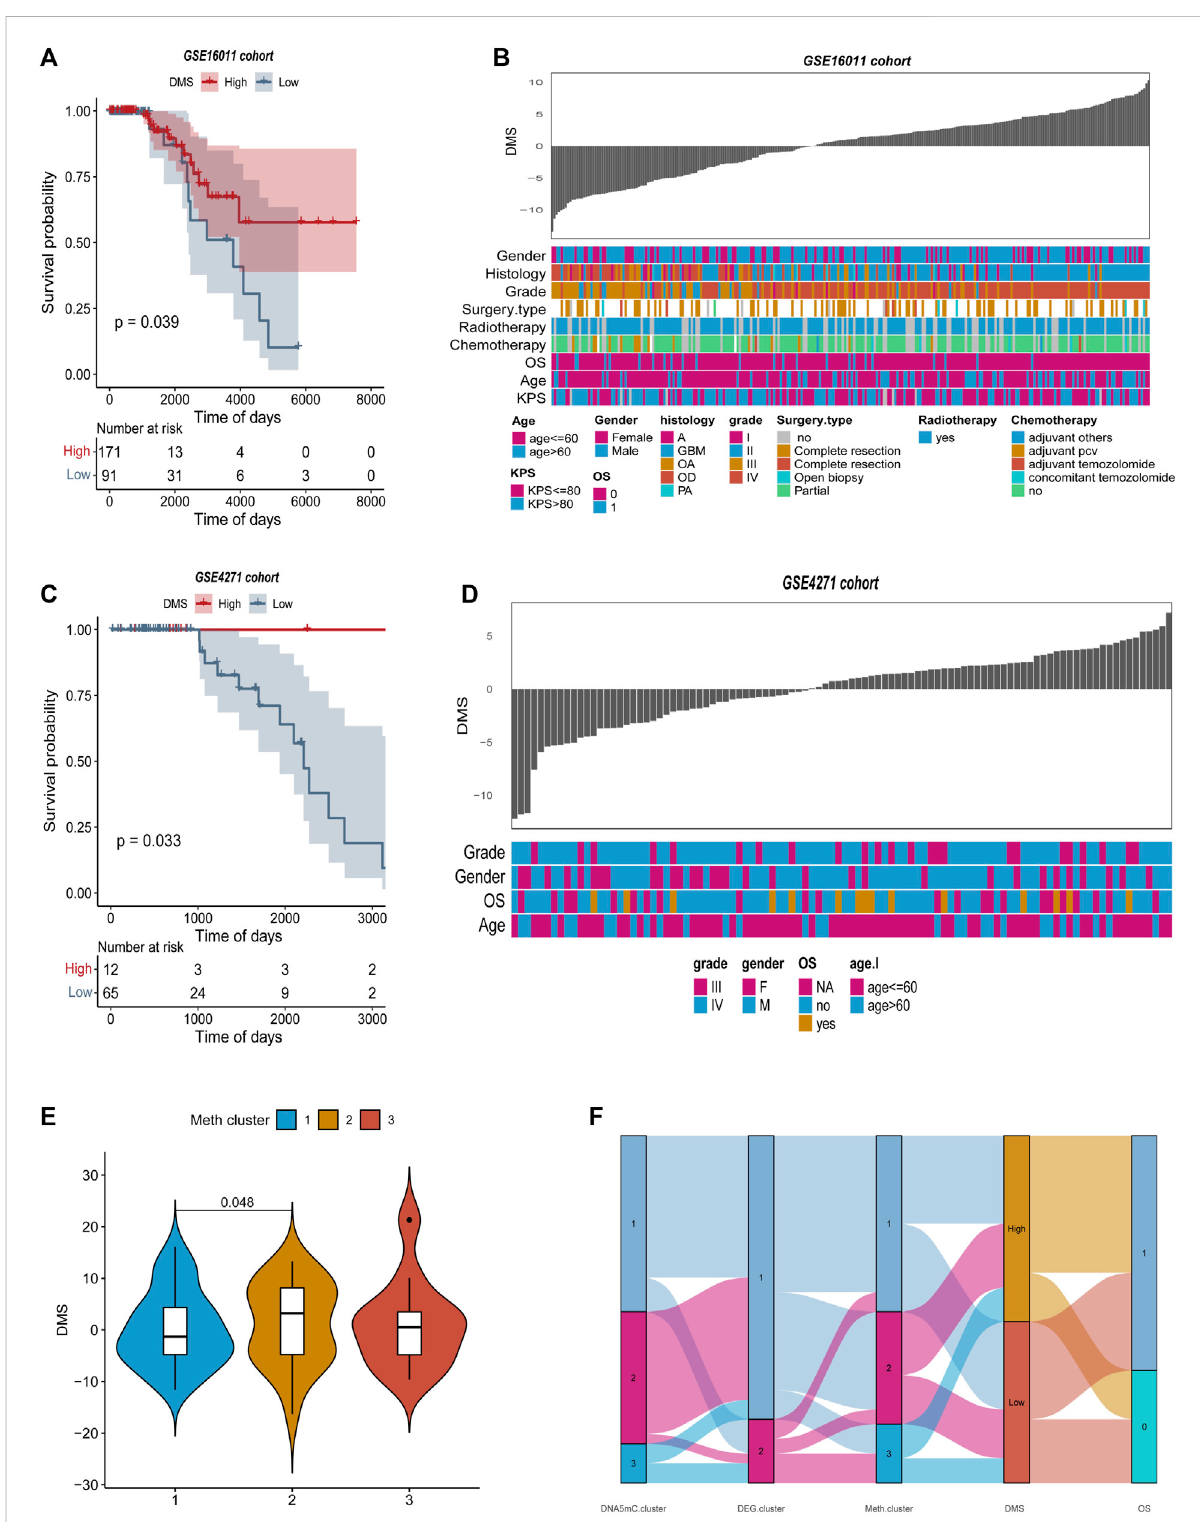
FIGURE 9 Features of tumor DNA methylation scores in external GEO cohorts. (A – B) Survival curves between high and low DMS groups in GSE16011 and GSE4271 datasets, separately. (C – D) Relationship between clinical special diagnosis and DMS distribution in GSE16011 and GSE4271 datasets, separately. (E) Different methylation subtypes differ in DMS. (F) A dynamic fl ow diagram illustrating each grouping and state transition of the tumor